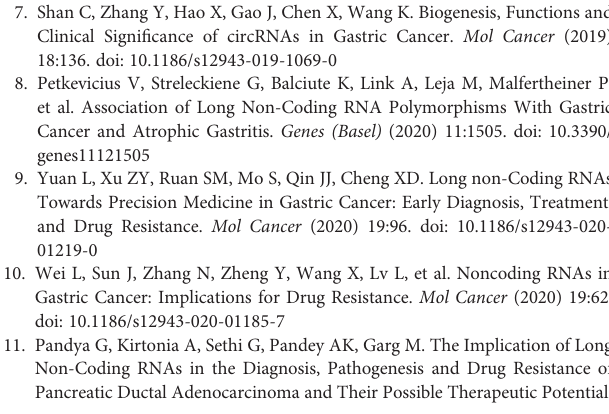
Supplementary Figure S1 | The correlation between miR-4256 expression level and the overall survival of patients with gastric cancer. The analysis was performed by using the online tool (Kaplan-Meier Plotter; https://kmplot.com/analysis).